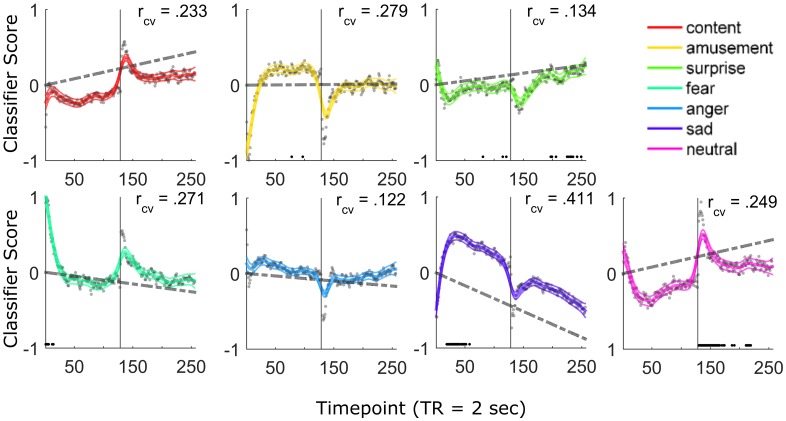
Emotional states exhibit coherence during resting-state scans.Gray circles reflect the sample mean classification scores for all seven emotions (n = 499). Thick colored lines display group-average predicted time course using smoothing splines (with bordering 95% confidence interval). Text overlay (rcv) indicates the average cross-validated correlation between splines fitted for each subject and tested on the average fit of other subjects. Dashed lines indicate linear fits over time. Solid black dots indicate time points at which a model has the highest proportion of classifications. Data are concatenated across two sessions of 256 s (solid vertical line). Note the early peak for fear scores and general increases in neutral scores over time. The data underlying this figure can be found in S1 Data. The raw fMRI resting state data can be obtained from https://www.haririlab.com/projects.